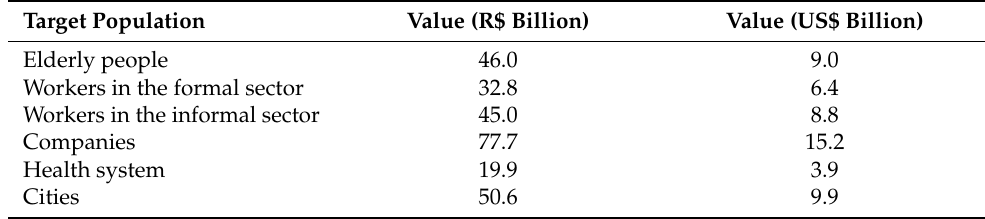
Table 2. Summary of the fiscal measures adopted by the government due to COVID-19. Target Population Value (R$